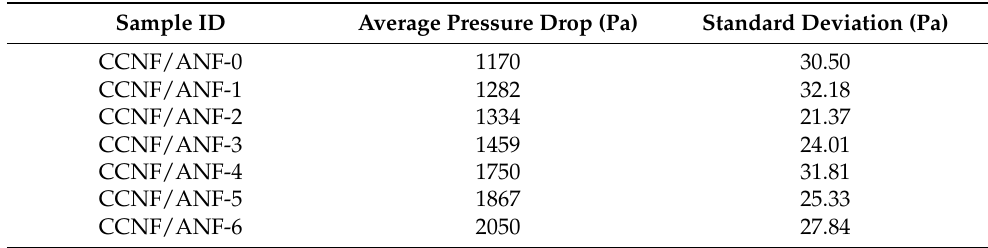
Table 2. Pressure drop performance of porous